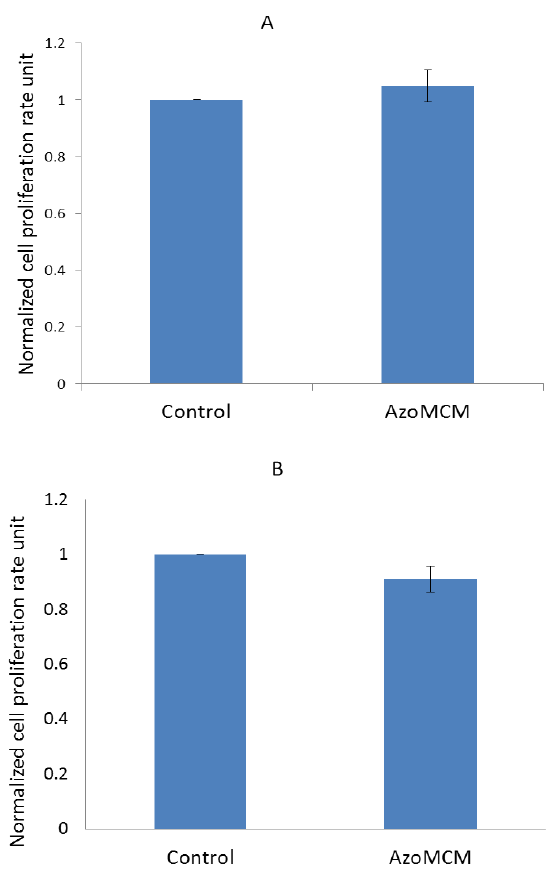
Figure 6. Normalized cell proliferation rate of A) NIH3T3 murine fibroblast cell line and B) B16F10 murine melanocyte cell